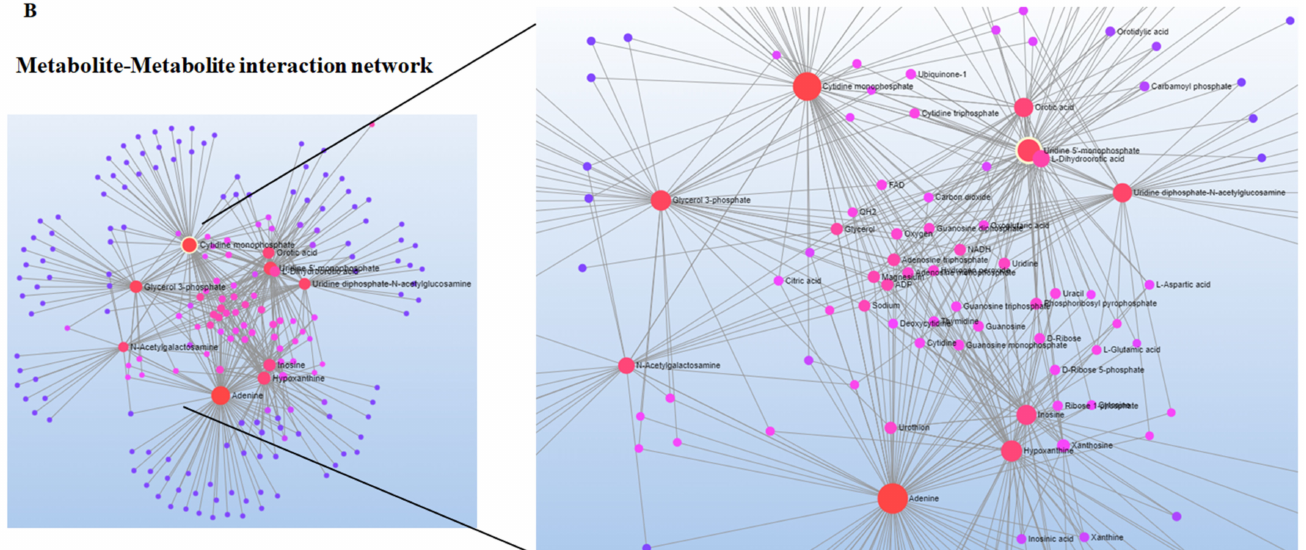
Figure 7. Metabolite interaction network. ( A ) Metabolite-gene-disease interaction network analysis of the annotated significantly differentially accumulated metabolites. The square blue boxes represent diseases, and significant metabolites are shown in red. ( B ) Metabolite–metabolite interaction network analysis of the annotated significantly differentially accumulated metabolites. The metabolites are represented as nodes (circles), and enzymes are represented as edges (lines). Metabolites with higher importance are highlighted in red followed by pink and blue. The size of the node indicates the node degree (the number of links a particular node has to other